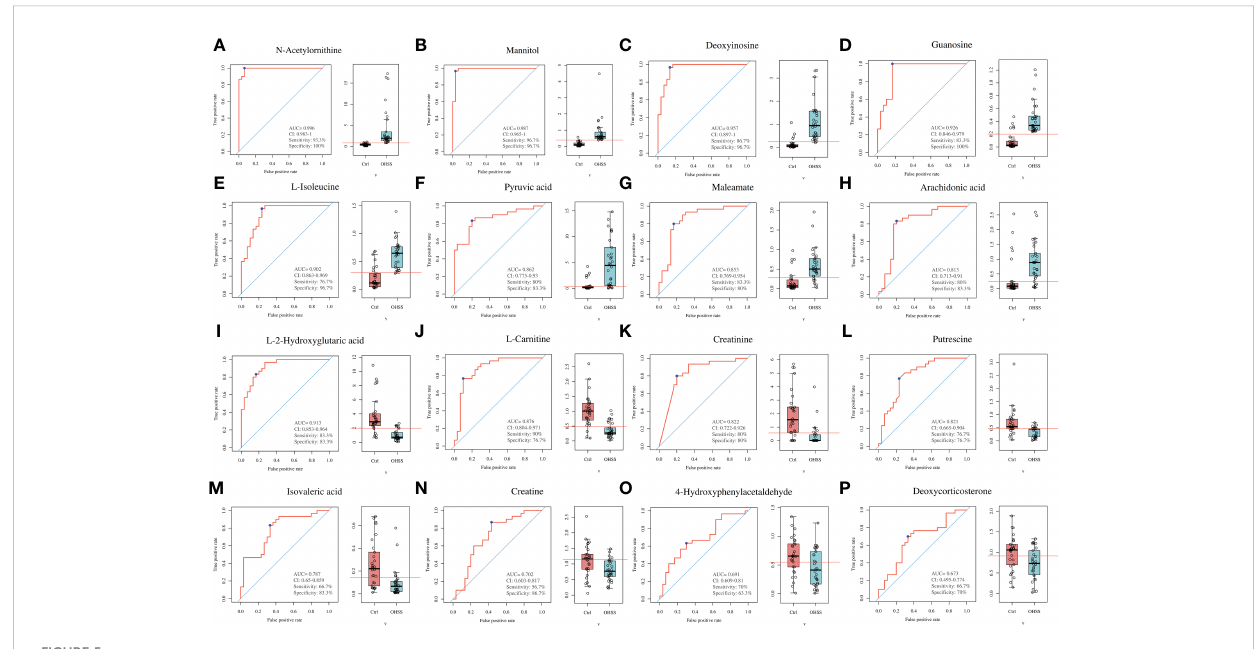
FIGURE 5 ROC curves of differentially changed metabolites in the FF of OHSS patients. (A) N-acetylornithine. (B) Mannitol. (C) Deoxyinosine. (D) Guanosine. (E) L-isoleucine. (F) Pyruvic acid. (G) Maleamate. (H) Arachidonic acid. (I) L-2-hydroxyglutaric acid. (J) L-carnitine. (K) Creatinine. (L) Putrescine. (M) Isovaleric acid. (N) Creatine. (O) 4-Hydroxyphenylacetaldehyde. (P)